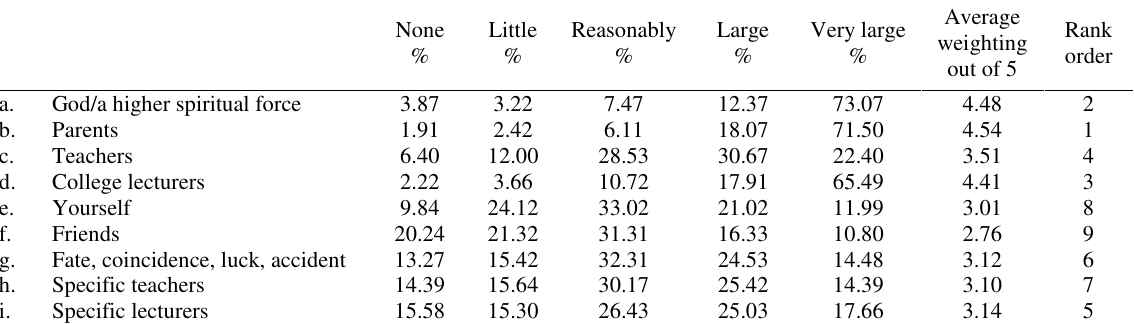
Table 4 The role of involved persons and factors on the character-development and character-building of